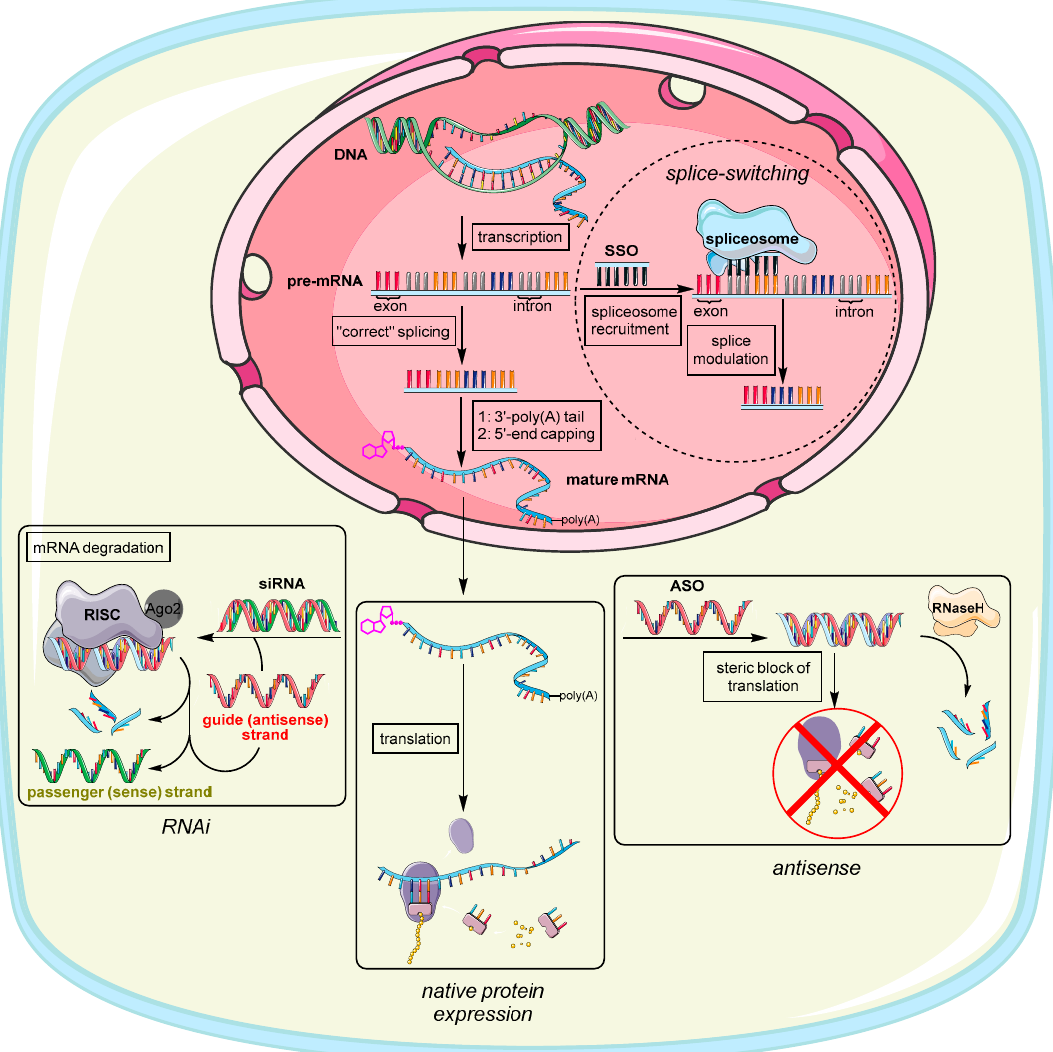
Figure 1. Principle modes of action of therapeutic ON in the nucleus and the cytosol in relation to